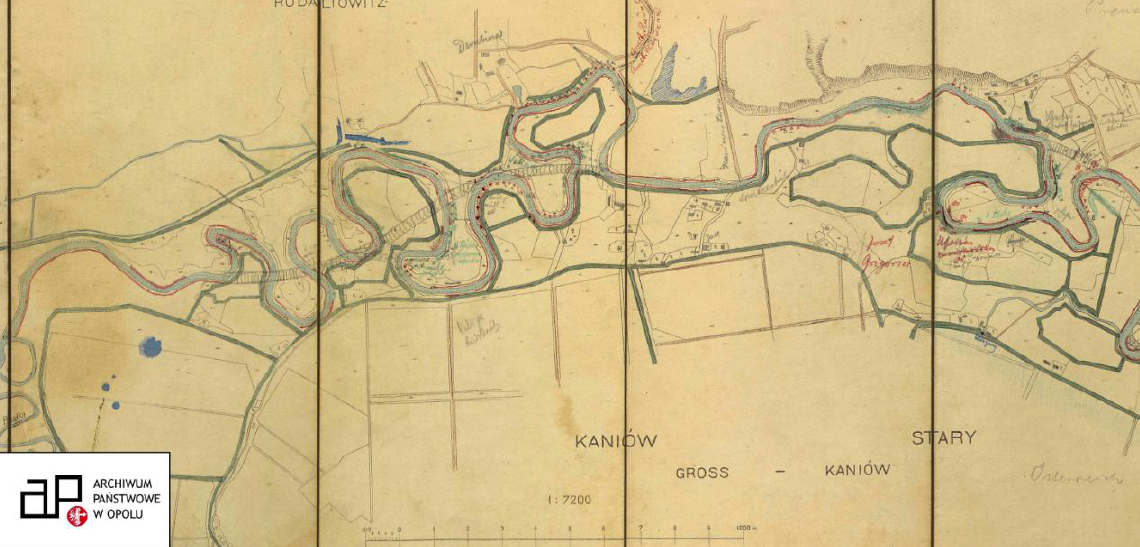
Fig. 11. River engineering work design – River Vistula valley in the vicinity of Kaniów (after Regulierung der…,